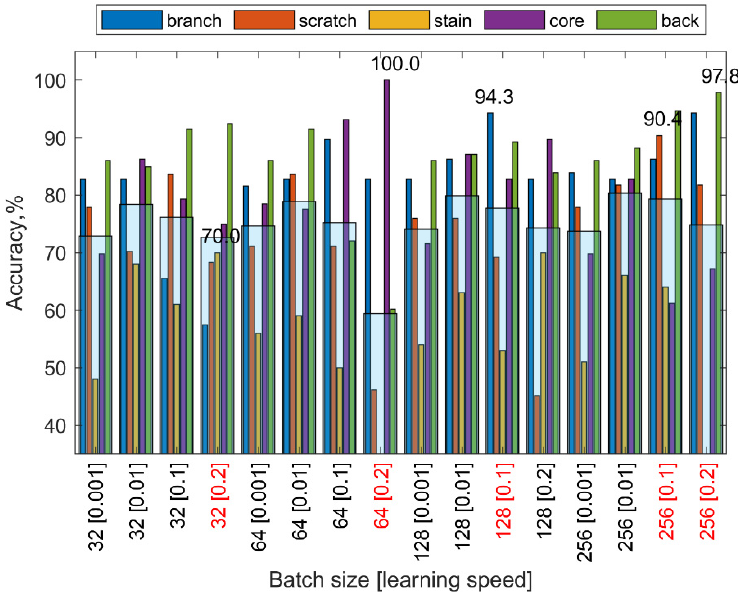
Figure 13. Classification accuracy using AlexNet neural network trained with different network parameters (batch size and learning speed). The best combinations of parameter values are indicated in red.